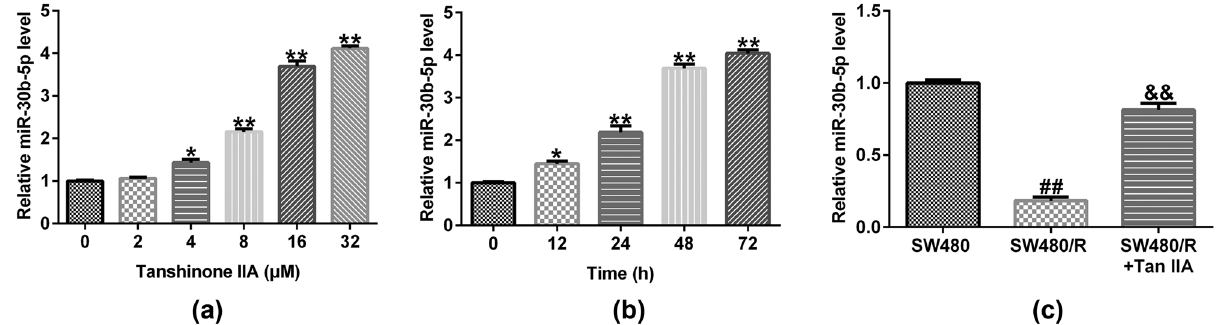
Figure 6: miR - 30b - 5p is upregulated inTan IIA simulatedSW480/Rcells. ( a ) RT - qPCRassaywasperformed to detect the miR - 30b - 5p expression level of di ff erent dosages of Tan - IIA - treated SW480/R cells. ( b ) RT - qPCR assay was conducted to appraise the level of miR - 30b - 5p in SW480/R cells following Tan IIA ( 16 μ M ) treatment for di ff erent time points. ( c ) RT - qPCR assay was conducted to appraise the level of miR - 30b - 5p in SW480 cells, SW480/R cells, and SW480/R cells treated with 16 μ M Tan IIA for 48h. Data are represented as the mean value ± SD of three